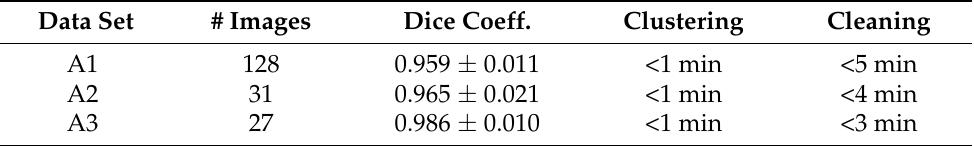
Table 2. Summary of accuracy and performance of semi-automated kmSeg segmentation on A1, A2, A3 sets of top-view plant images from [8] in terms of the average Dice coefficient of similarity between kmSeg-segmented and ground truth images ( ± standard deviation). Columns ’Clustering’ and ’Cleaning’ indicate the maximum time span required for image segmentation using automated k-means clustering followed by optional manual